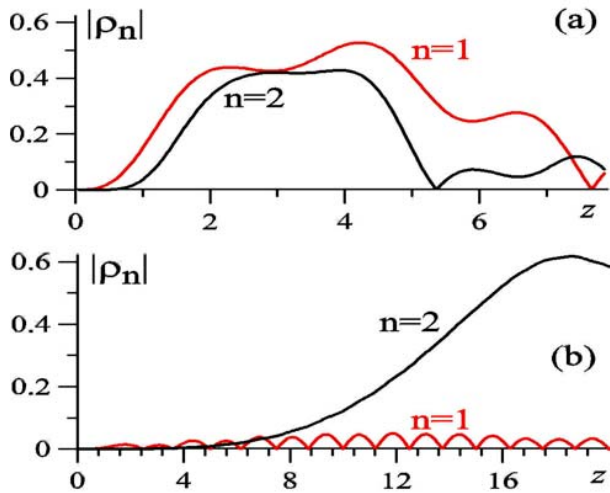
FIG. 3. (Color) Results of simulations of universal asymptotic equations (2) in the cases of the uniform wave amplitude (a) and of a smooth entrance of electrons into the interaction region (b). First and second harmonics of the electron current versus the axial